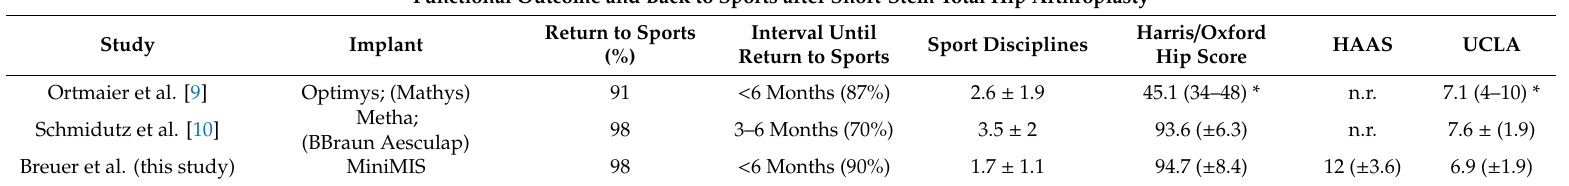
Table 4. Functional outcome and back to sports after short-stem total hip arthroplasty. Overview of current literature. Values are depicted as arithmetic mean and standard deviation unless marked otherwise. * Values depicted as median and